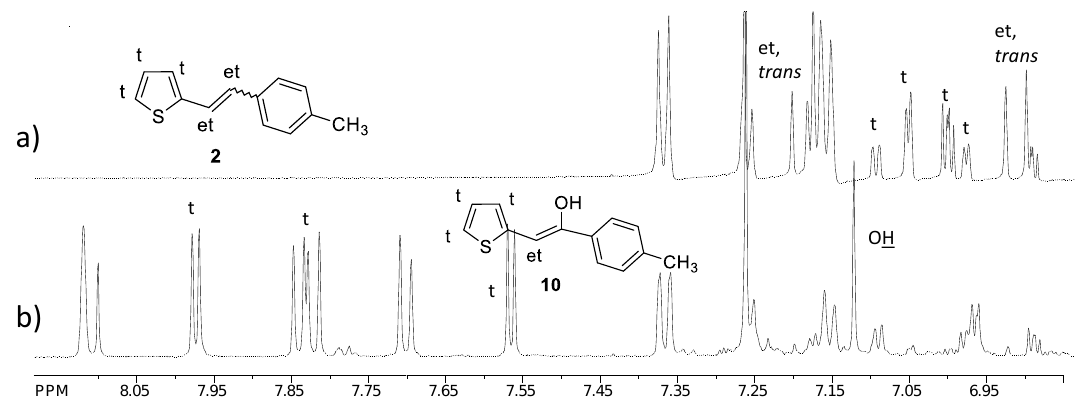
Figure 7. Aromatic parts of 1 H NMR spectra (CDCl 3 ) of the starting thienyl derivative 2 ( a ) and the major photooxygenation product 10 ( b ) with characteristic pattern for assignation of the specific structures.